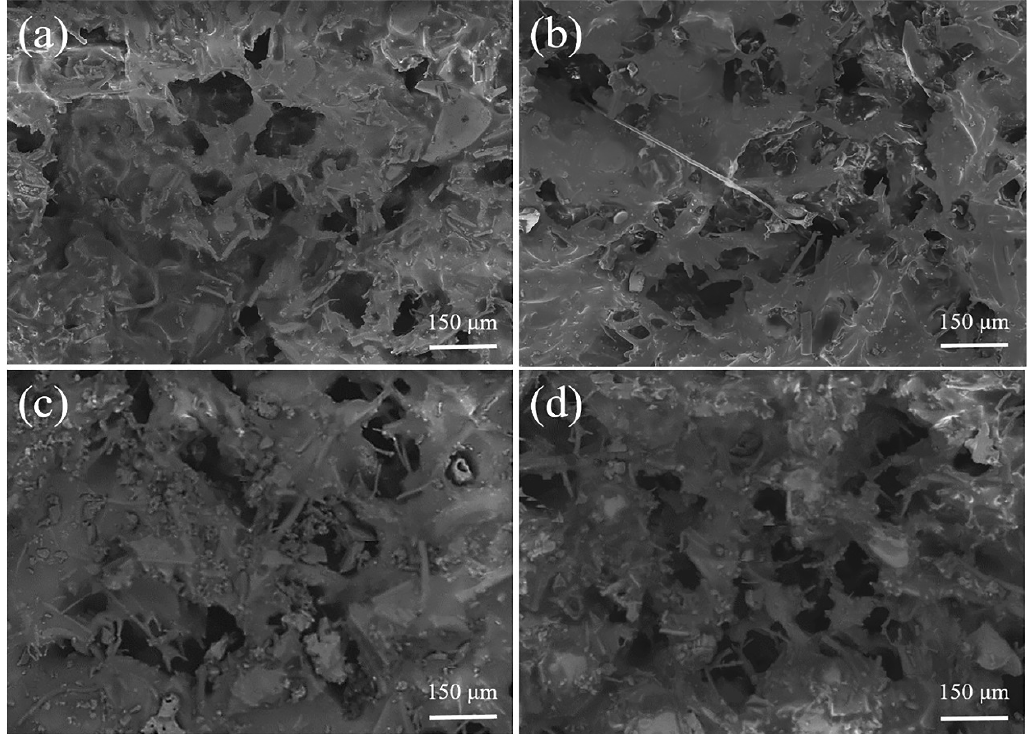
Figure 7. Porous structure of PDMS-ceramic aeration membrane at different evaporation stages: ( a ) original PDMS-ceramic aeration membrane; ( b ) the solution was evaporated to a nearly saturated state; ( c ) the evaporative rate decreases to 0 kg m − 2 h − 1 ; and ( d ) after recovery treatment.